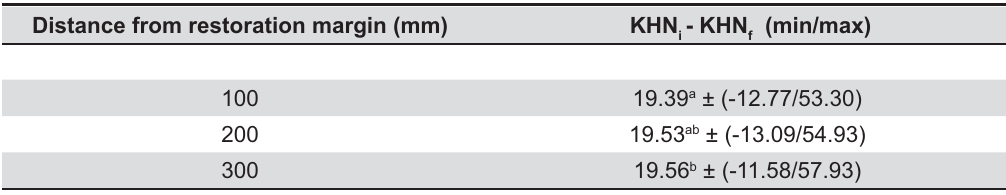
Table 1- (cid:6)(cid:25)(cid:7)(cid:4)(cid:14)(cid:9)(cid:19)(cid:1)(cid:6)(cid:15)(cid:16)(cid:6)(cid:2)(cid:11)(cid:7)(cid:6)(cid:4)(cid:14)(cid:16)(cid:16)(cid:7)(cid:13)(cid:7)(cid:19)(cid:12)(cid:7)(cid:1)(cid:6)(cid:30)(cid:7)(cid:2)(cid:22)(cid:7)(cid:7)(cid:19)(cid:6)(cid:14)(cid:19)(cid:14)(cid:2)(cid:14)(cid:9)(cid:10)(cid:6)(cid:9)(cid:19)(cid:4)(cid:6)!(cid:19)(cid:9)(cid:10)(cid:6)(cid:4)(cid:7)(cid:19)(cid:2)(cid:14)(cid:19)(cid:6)(cid:21)(cid:14)(cid:12)(cid:13)(cid:15)(cid:11)(cid:9)(cid:13)(cid:4)(cid:19)(cid:7)(cid:1)(cid:1)(cid:6)$"(cid:130)(cid:131) values, considering all of the restorative systems and treatments at 100, 200 and 300 mm distances